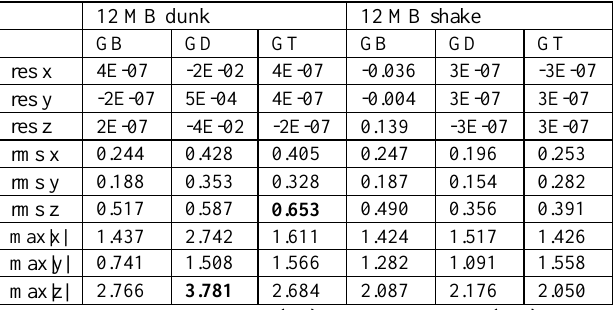
Table 10: Average residual (res), root mean square (rms) and maximal absolute residual value (max|x|) of all check points in mm (12MB dunk and shake) after removing the sequences containing errors and after removing the systematic trend.